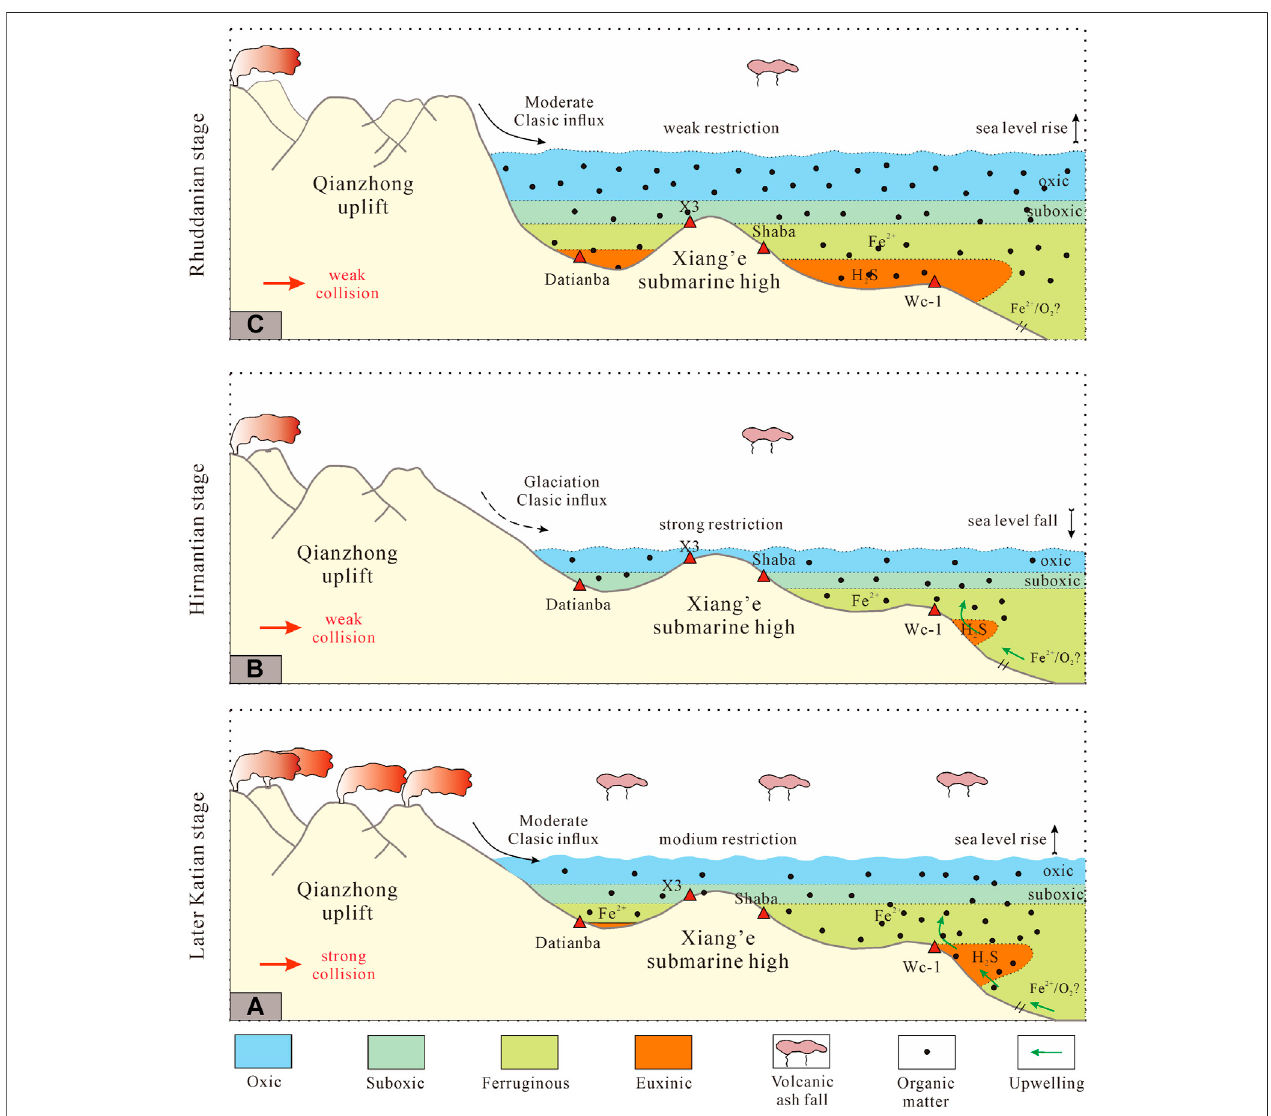
FIGURE 9 | Depositional model of A — A ’ ( Figure 1C ) during the O — S period: (A) Late Katian. Ferruginous conditions associated with terrigenous clastic inputs develop in shallow water, and euxinia associated with upwelling and higher organic matter fl uxes develop in deep water. (B) Hirnantian. Affected by the decline of sea level, euxinia water gradually fades away in the basin. (C) Rhuddanian. Affected by sea level rise and high organic matter fl ux, euxinia water expands from deep water to shallow water.